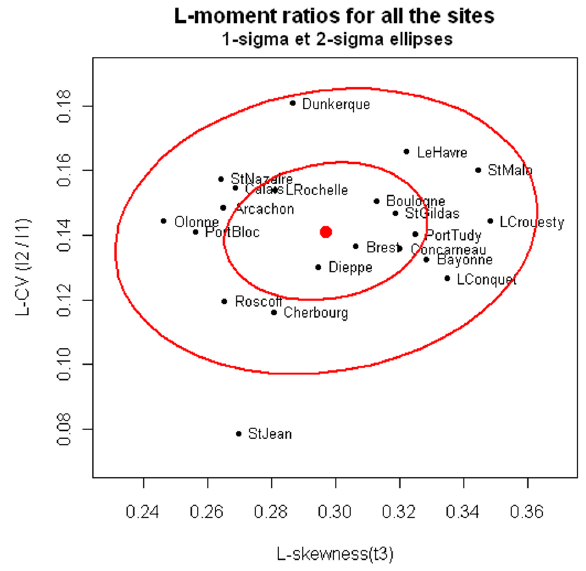
Fig. 6. Homogeneity test for the region with all the available har- bours: comparison of the L-moment ratios with the graph of L- skewness versus L-CV. The point corresponding to the sample of Saint-Jean-de-Luz is outer the 2-sigma ellipse and it seems to be an unusual site for the